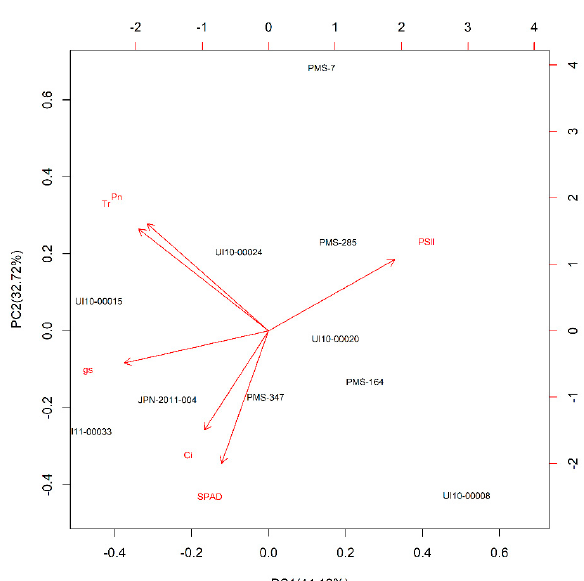
Figure 3. Principal component analysis (PCA) bi-plot of the drought stress index (DSI) of six physiological traits: photosynthetic rate (Pn), stomatal conductance (gs), transpiration rate (Tr), intercellular CO 2 concentration (Ci), the Soil Plant Analysis Development (SPAD) Chlorophyll meter value, chlorophyll fluorescence (PSII) under 25% soil moisture in a precise-comparison experiment at Hokkaido University, Sapporo, Japan. Arrows represent physiological traits with various lengths, which were based on the impact of each trait on the separation of genotypes.